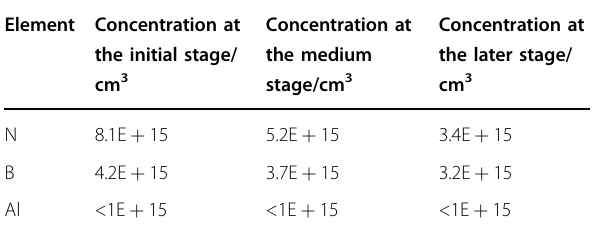
Table 1 The impurity concentration measured by SIMS in 6-inch HPSI SiC crystals at different stage of growth